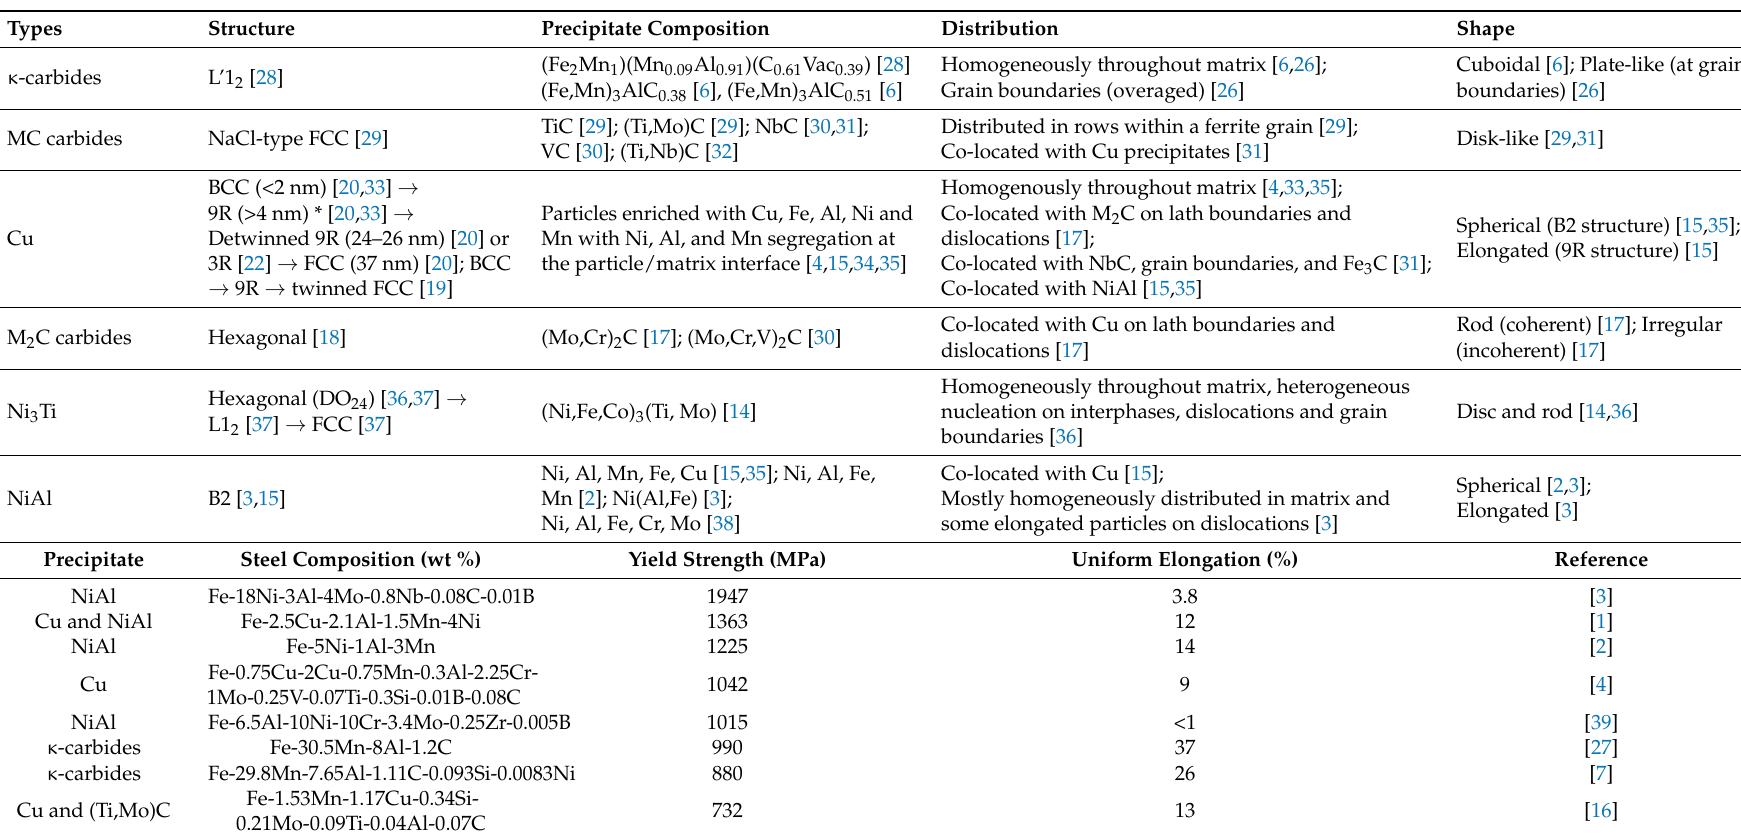
Table 2. The structure, composition, distribution, and size of various precipitates in